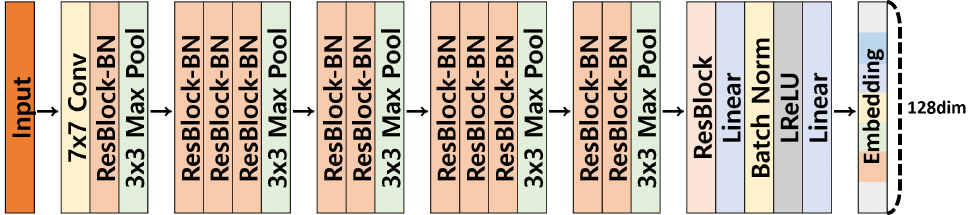
Figure 2. The architecture of our feature extractor. The ResBlock-BN means a resnet block